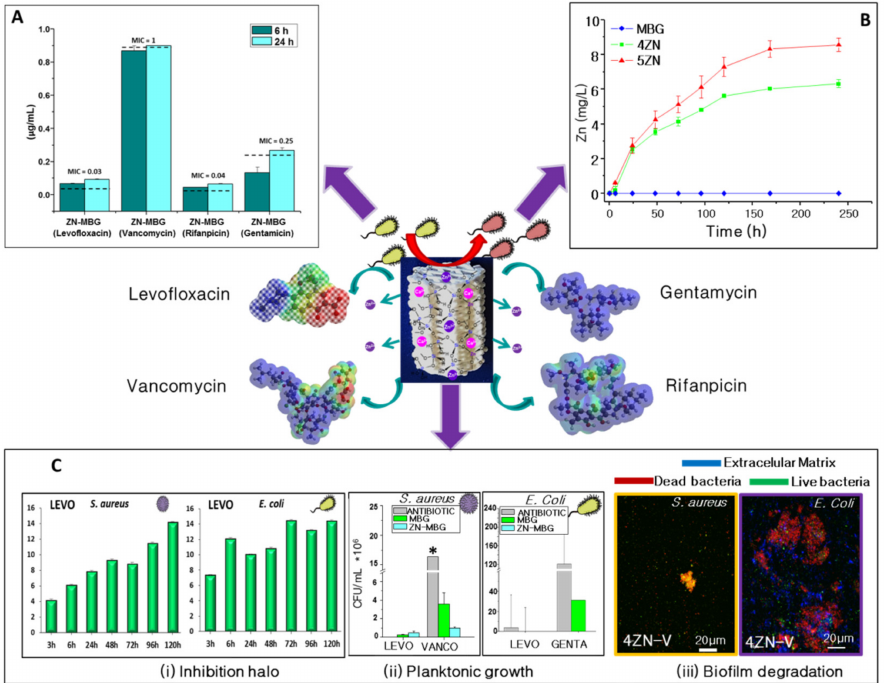
Figure 9. Representative scheme of Zn-MBG scaffolds loaded with antibiotics. ( A ) Antibiotic release from Zn-MBG scaffolds at physiological pH after 6 and 24 h (MIC, Minimum inhibitory concentration). ( B ) Evolution of zinc release from 4% ZnO (4ZN-MBG) and 5% ZnO (5ZN-MBG) enriched MBG scaffolds in the THB medium. ( C ) (i) Levofloxacin-loaded scaffold inhibition rate against S. aureus and E. coli at pH 7.4 (physiological environment). (ii) Planktonic growth of S. aureus and E. Coli in contact with antibiotic (Levofloxacin, vancomycin and gentamicin)-loaded MBG and Zn-MBG scaffolds * indicate significant differences between samples where the antibiotic is loaded within the scaffold and those where the drug is dissolved in the medium. Statistical significance: p < 0.05. (iii) Biofilm degradation with vancomycin-loaded Zn-MBGscaffolds after 24h. Reproduced with permission from Heras et al. [19], Acta Biomater.; published by Elsevier,